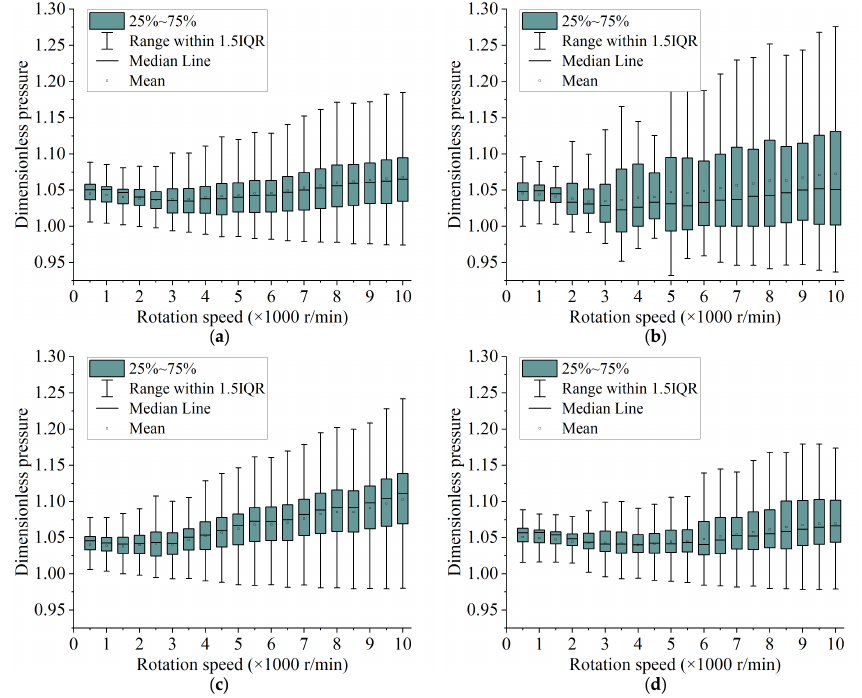
Figure 7. Box charts of surface pressure distribution: ( a ) shaft 1; ( b ) shaft 2; ( c ) shaft 3; ( d ) shaft